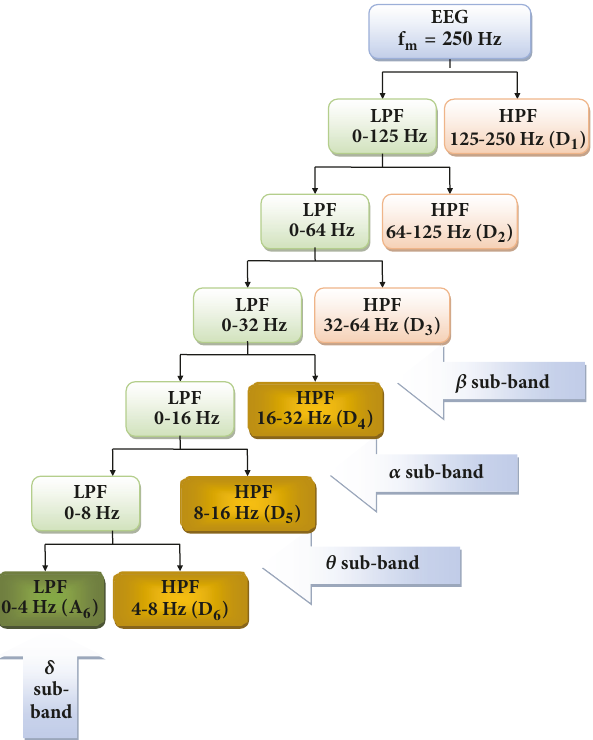
Figure 3: Application of DWT to generate subbands of EEG. Different levels of decomposition of DWT are shown. A6, D6, D5, and D4 yield delta, theta, alpha, and beta waves, respectively. fm: maximum frequency content of the EEG